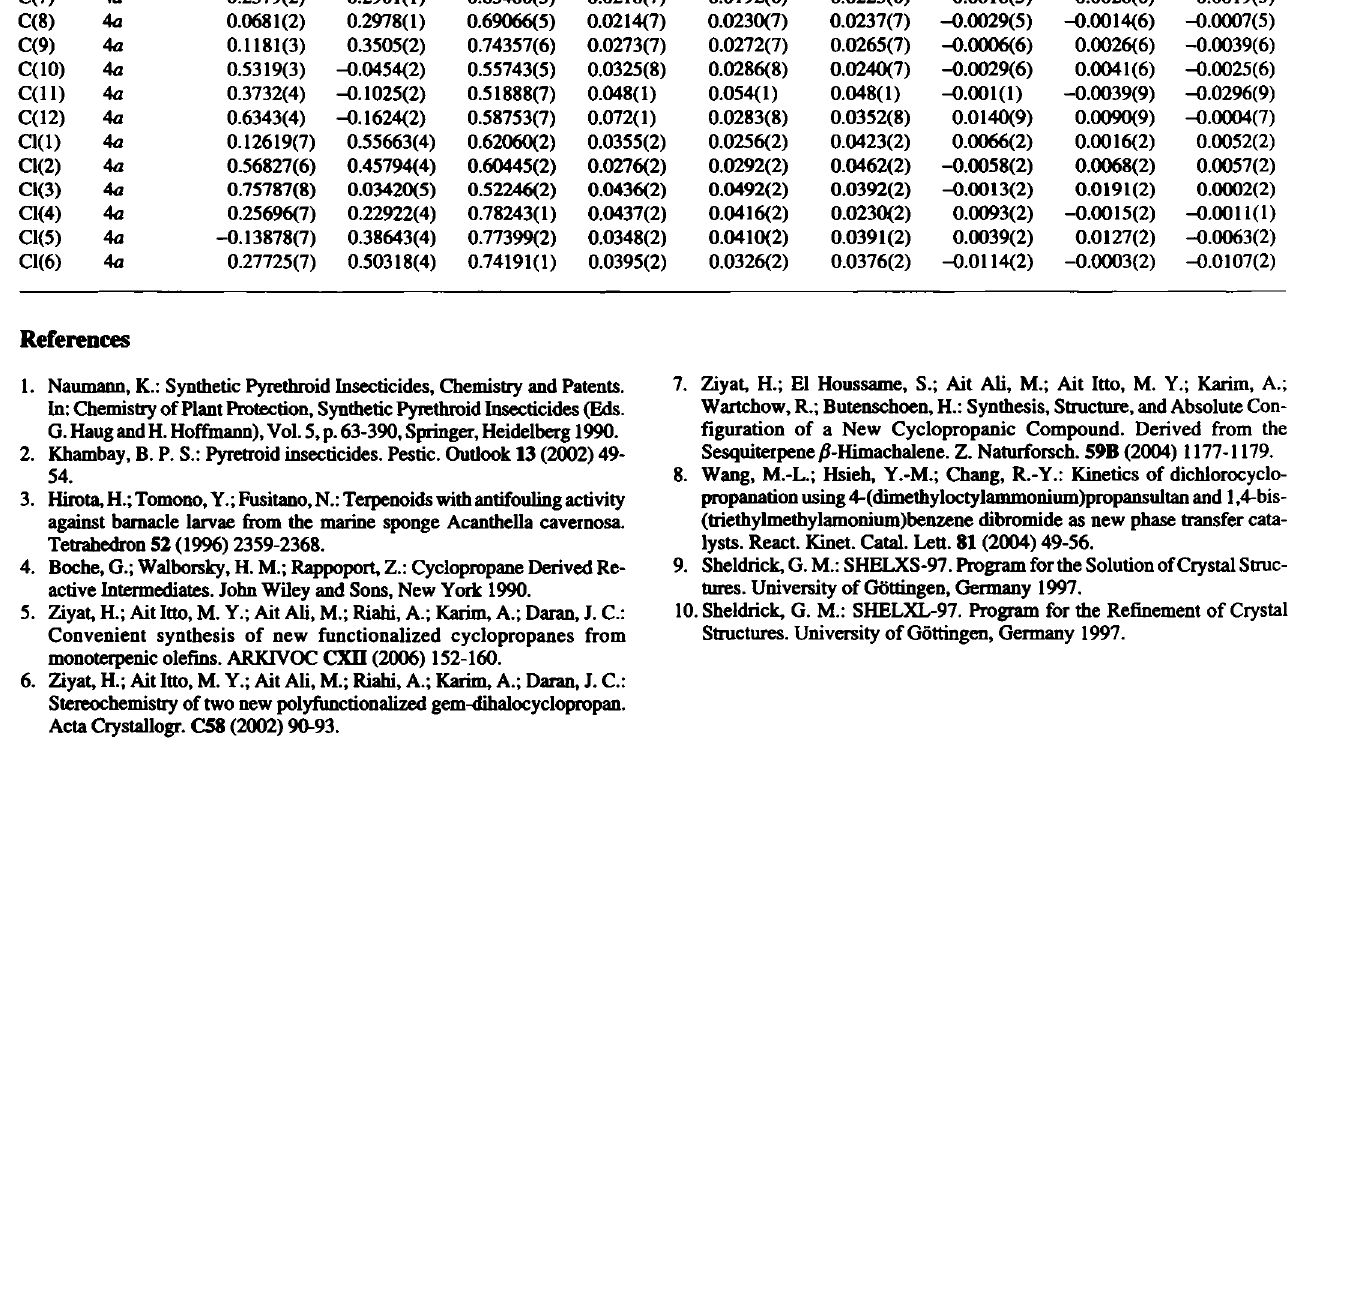
Table 3. Atomic coordinates and displacement parameters (in Â 2